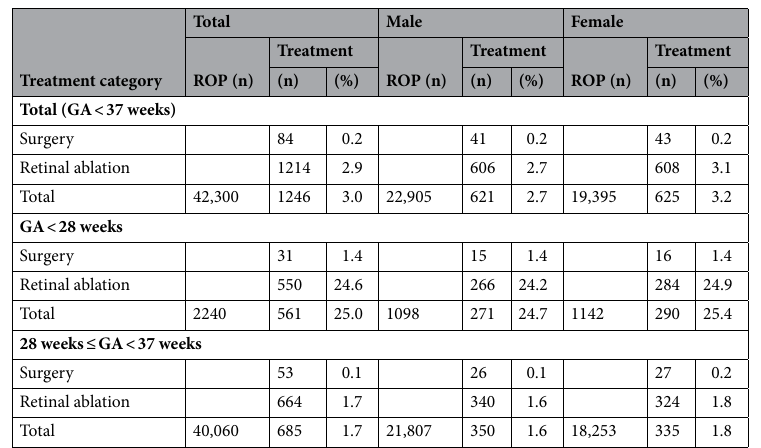
Table 3. The percentage of patients with retinopathy of prematurity who underwent treatment during the 12-year of study period according to gestational age and sex. GA gestational age, ROP retinopathy of prematurity.